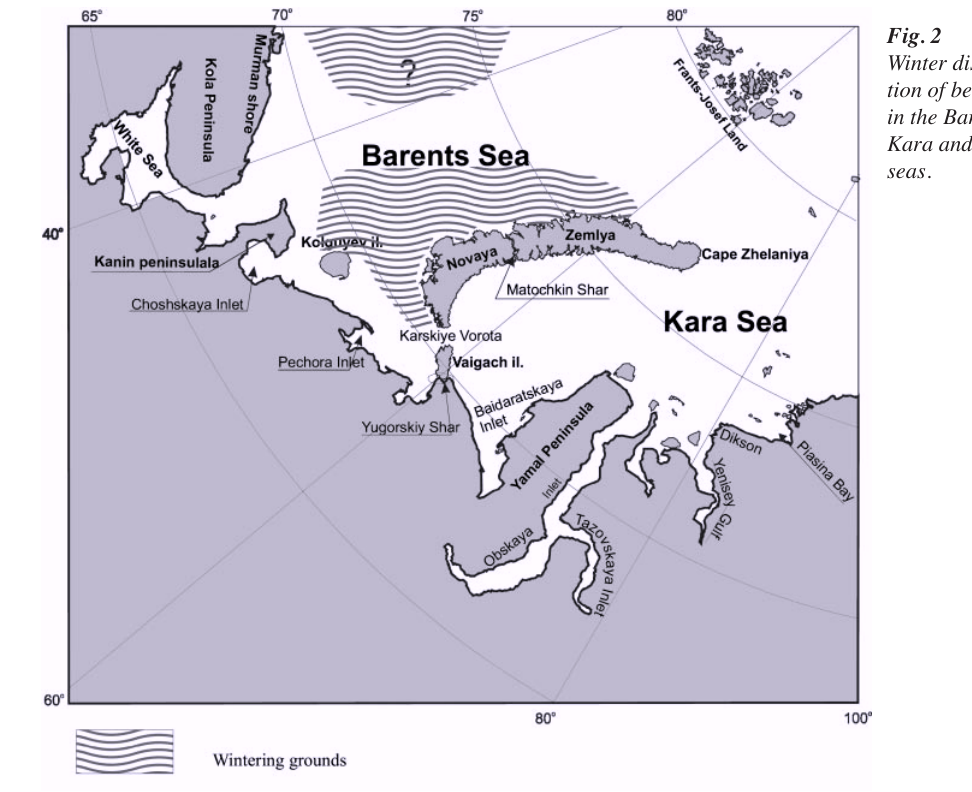
Winter distribu- tion of belugas in the Barents, Kara and Laptev seas.